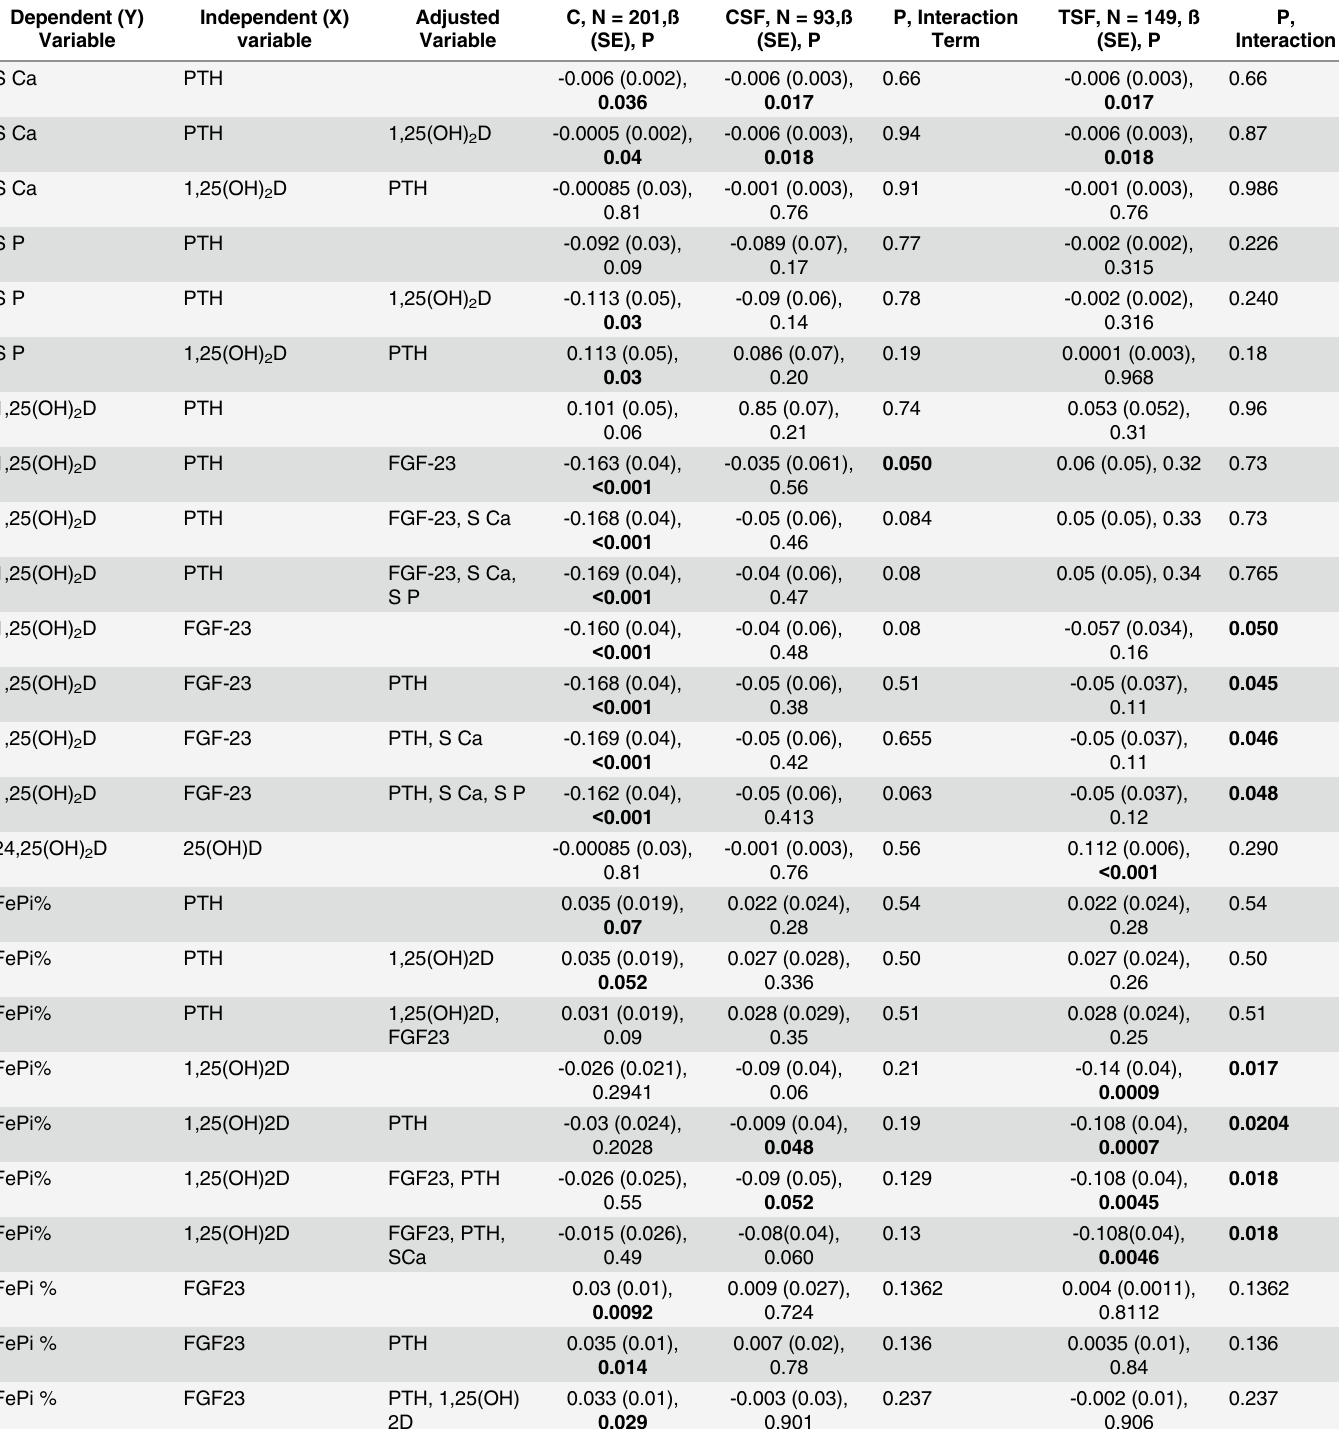
Table 2. Multivariable regression analysis of dependent variable (Y) on independent variable (X). Columns include adjusting variables (in addition to age and sex), parameter or slope estimate (ß), standard error (SE), and P value (test of slope = 0) for analyses done within stone former and control groups, Also given is the P value for the interaction term (test for common slopes) between X and stone group from similar models pooling stone-formers and controls. CSF = confirmed Ca stone formers; TSF = total stone formers (confirmed plus